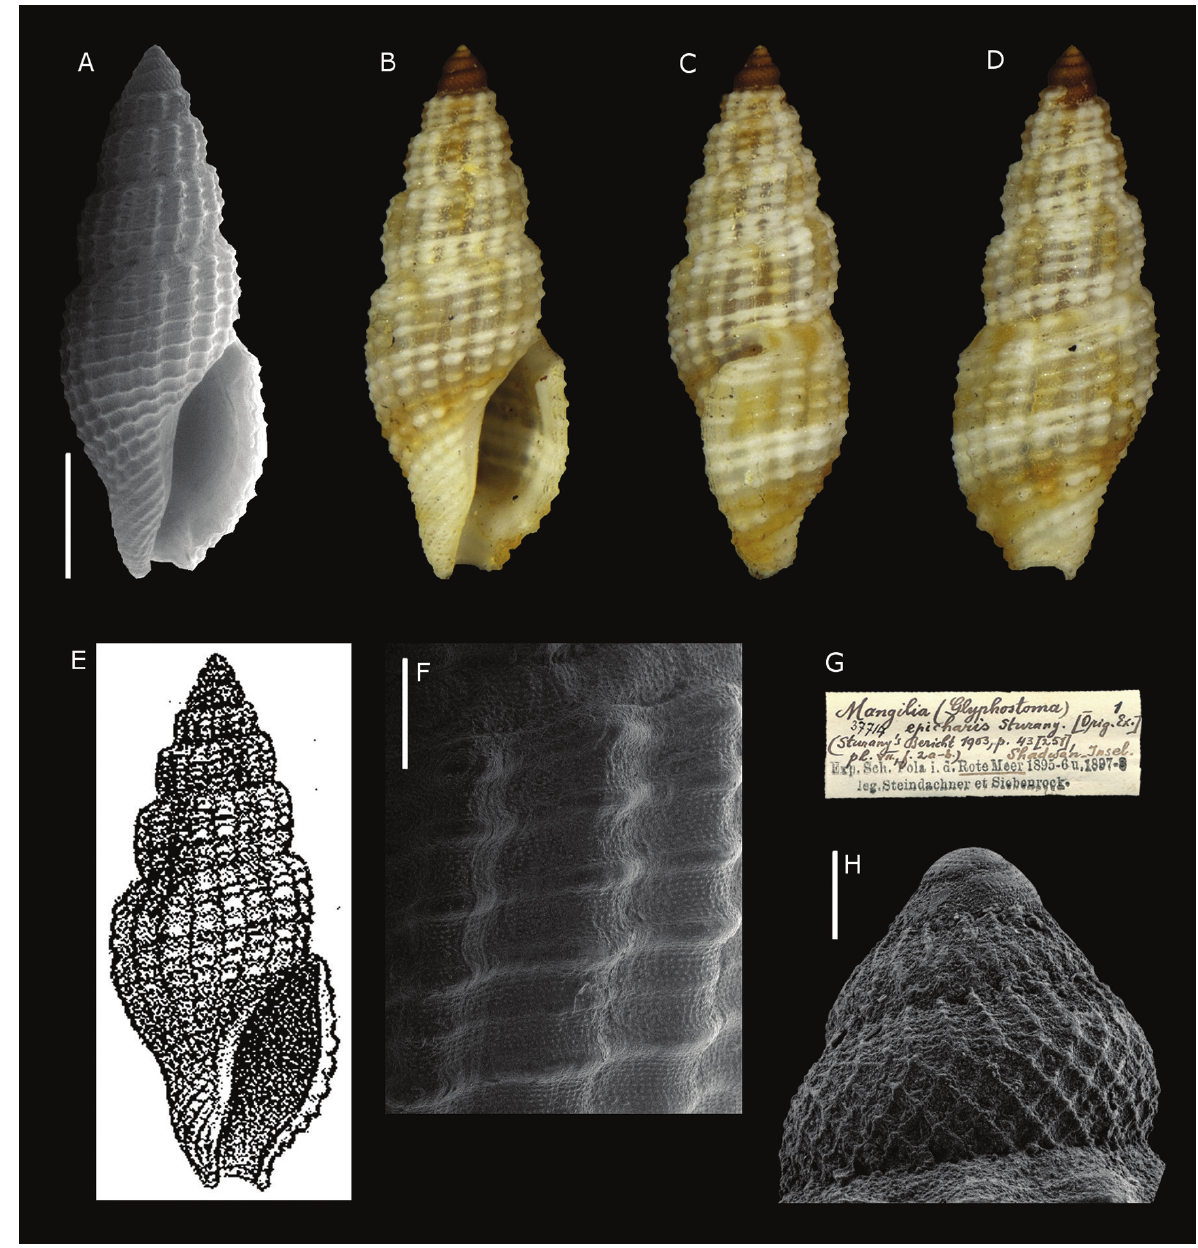
Figure 30. Mangelia epicharis Sturany, 1903, Locality 16 (Jazirat Shakir, Egypt, Red Sea). A–D , F , H . Holotype, NHMW 37714: front ( A–B ), right side ( C ), back ( D ), microsculpture ( F ), protoconch ( H ). E . Original figure by Sturany (1903). G . Original holo- type label. Scale bars: A–D : 0.5 mm, F : 0.2 mm, H : 0.1 mm.